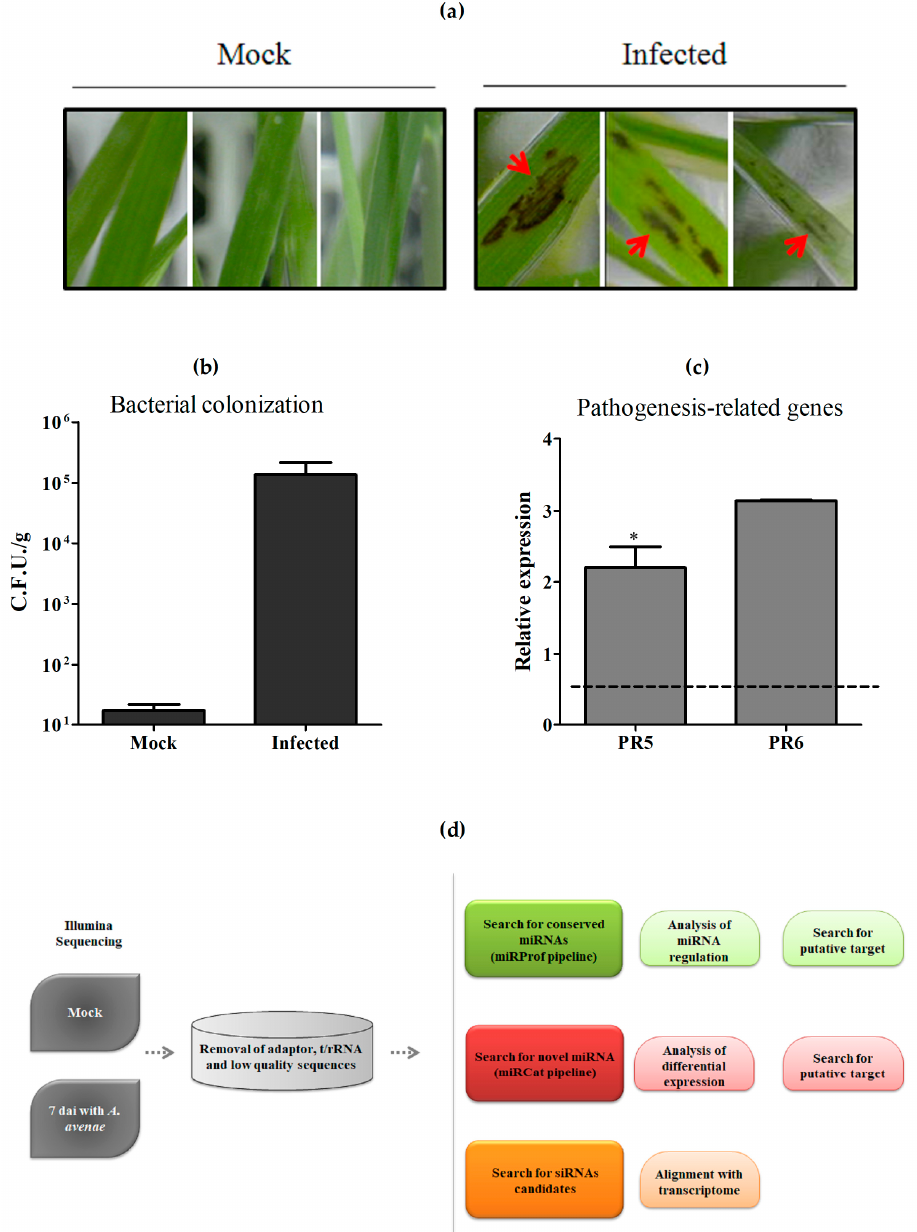
Figure 1. Plant treatment and analysis pipeline employed. ( a ) Photograph of sugarcane plants 7 days after inoculation with Acidovorax avenae. Red arrows show spots present in all infected plants, but not in control mock-inoculated plants. ( b ) Counts of bacterial colonization by MPN (Most Probable Number) estimation using mock and infected plants after 7 days of inoculation with A. avenae . The values show the average bacterial number counted in two experiments. ( c ) Analysis of two pathogenesis-related genes, PR5 and PR6, in response to the inoculation of A. avenae using real-time PCR. The error bars represent the standard deviation between three technical replicates. * represents significant changes of target gene expression between control and inoculated samples ( p -value < 0.05). Dashed line represents the control. ( d ) Pipeline followed to analyze sugarcane sRNA from mock-inoculated and pathogen-infected samples. C.F.U.: Colony Forming Units.